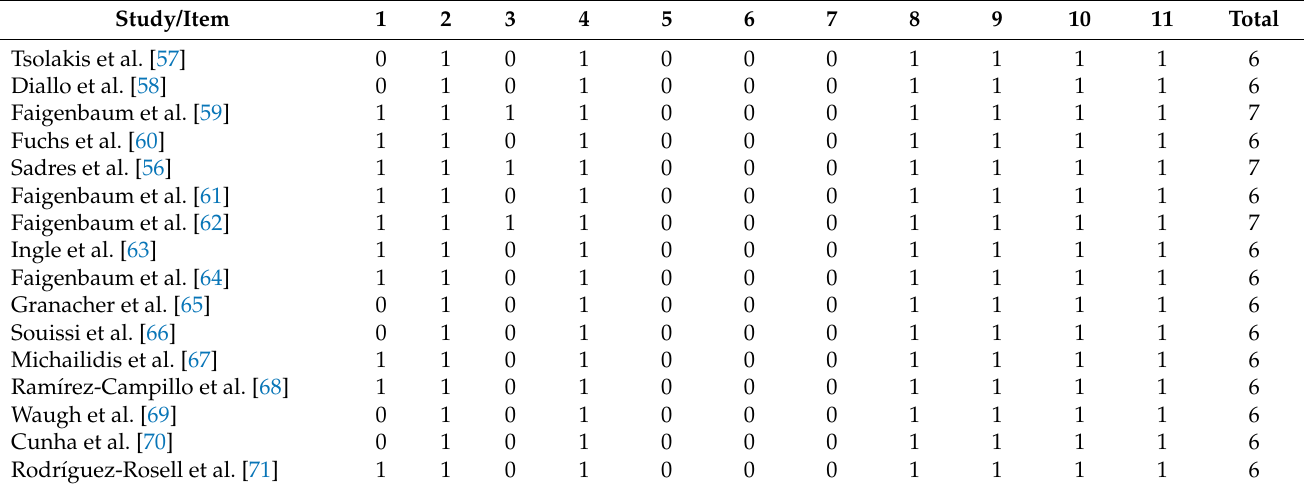
Table 5. External and internal quality assessment — PEDro scale.